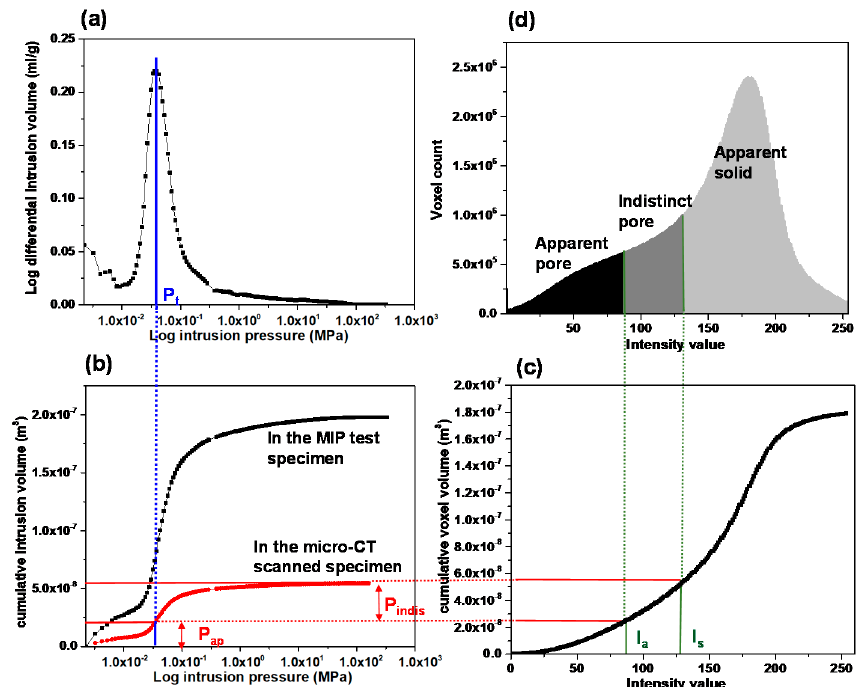
Figure 2. Segmentation and designation processes for three-phase materials consisting of apparent pores ( P ap ), indistinct pores ( P indis ) and apparent solid ( S ap ). Data were obtained from the MIP test ( a , b ) and the micro-CT image process on a case of Boise sandstone ( c , d ).